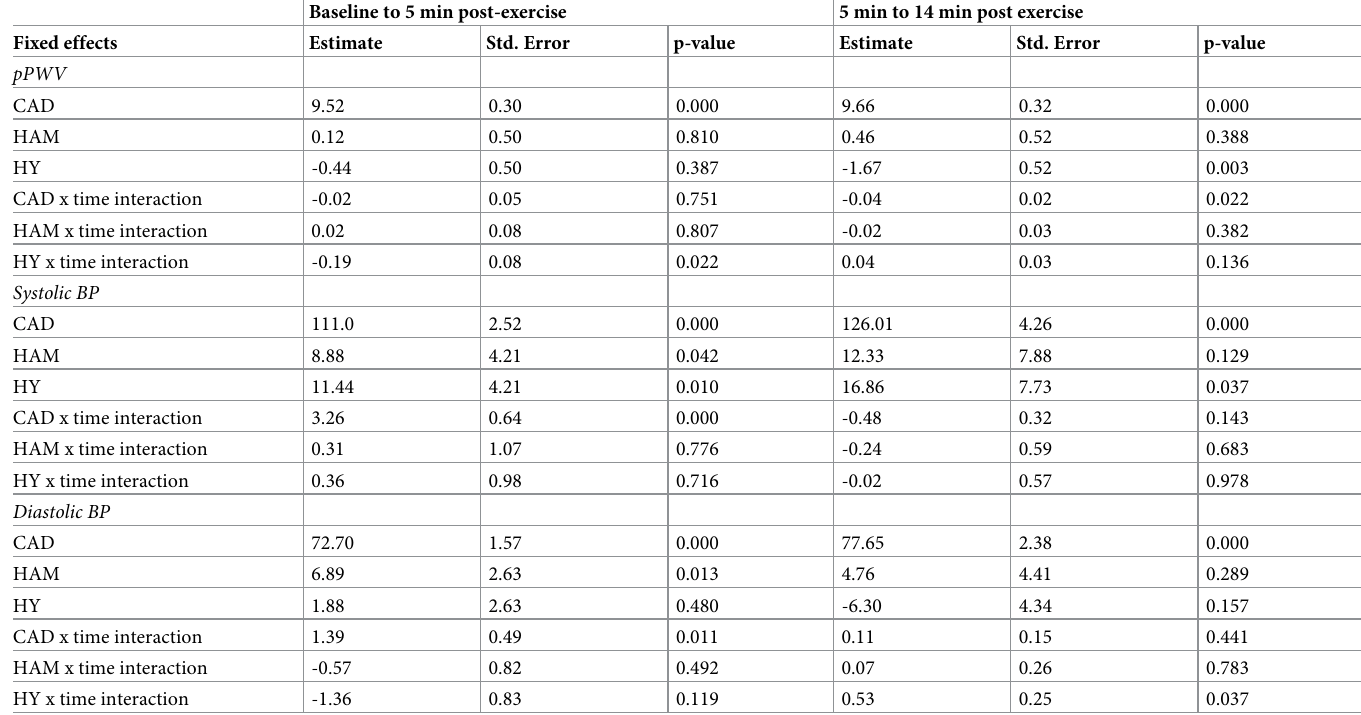
Table 3. Mixed linear models for pPWV and systolic as well as diastolic BP. Baseline to 5 min